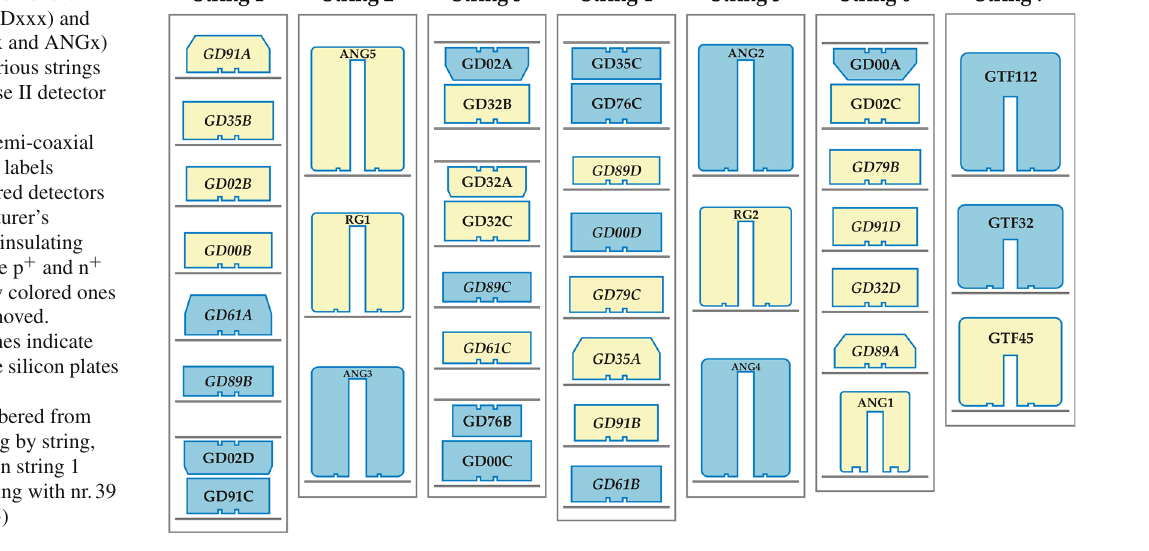
Fig. 33 Distribution of the enriched BEGe (GDxxx) and semi-coaxial (RGx and ANGx) detectors in the various strings of the Gerda Phase II detector array; the natural low-background semi-coaxial detectors carry the labels GTFxx. Blue colored detectors carry the manufacturer’s passivation on the insulating groove between the p + and n + contact; the yellow colored ones have this layer removed. Horizontal grey lines indicate the positions of the silicon plates (see Fig. 3). Detectors are numbered from top to bottom string by string, starting with nr.0 in string 1 (GD91A) and ending with nr.39 in string 7